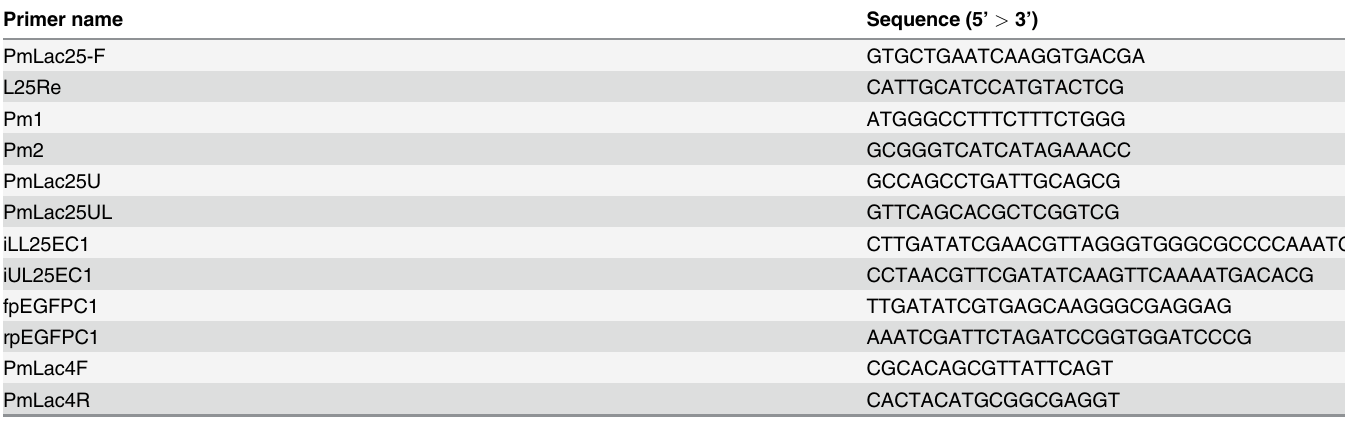
Table 1. List of primers used in this